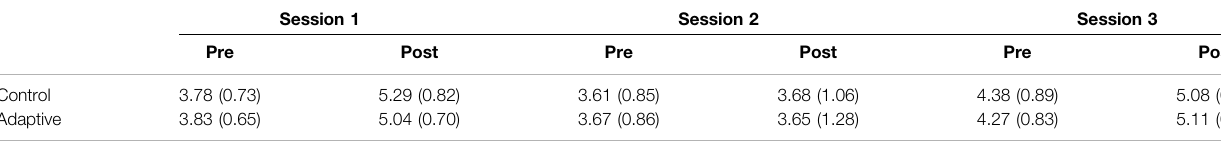
TABLE 2 | Results of 2 × 2 mixed ANOVAs for subjective knowledge. * indicates signi fi cance. Session Condition (control, adaptive) – F